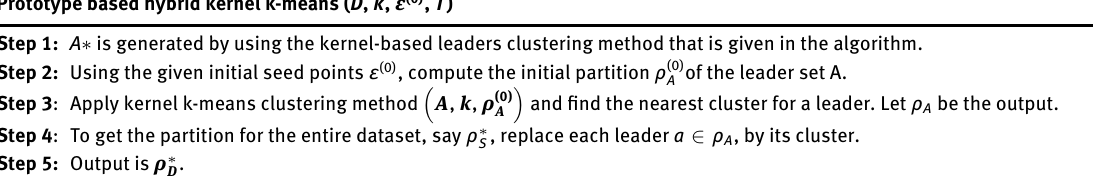
Table 2: Proposed Prototype Based Hybrid Kernel k-Means. Prototype based hybrid kernel k-means ( D , k , ε (0) , T )